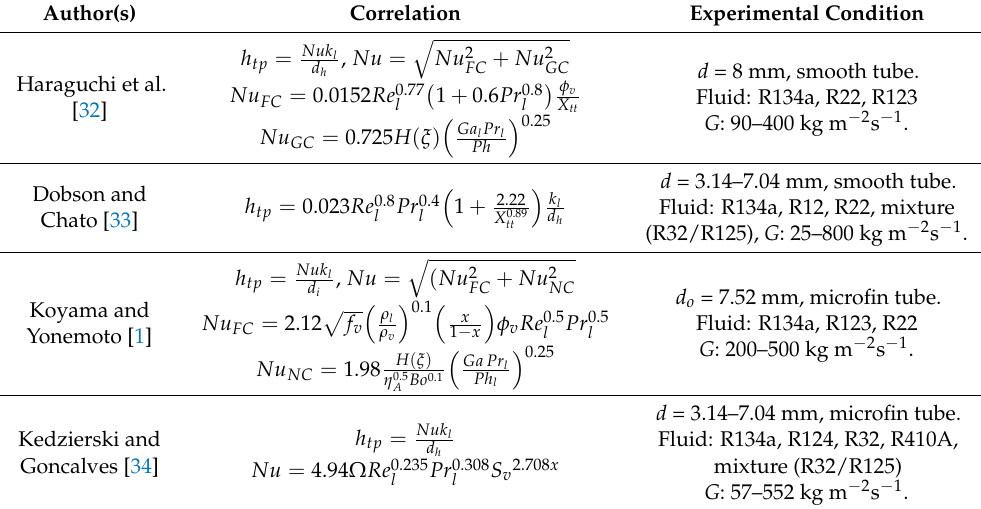
Table 5. Condensation heat transfer correlations.